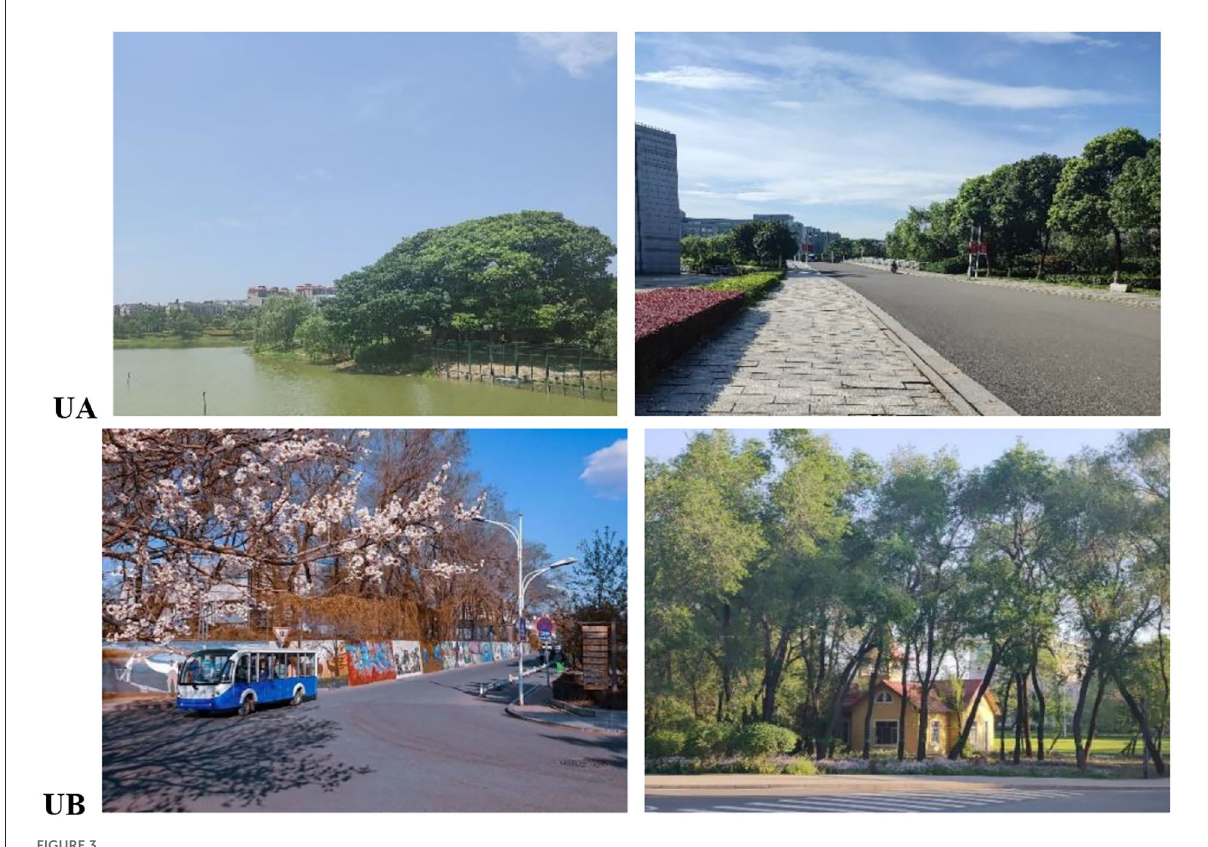
FIGURE3 Scenes of the studied university